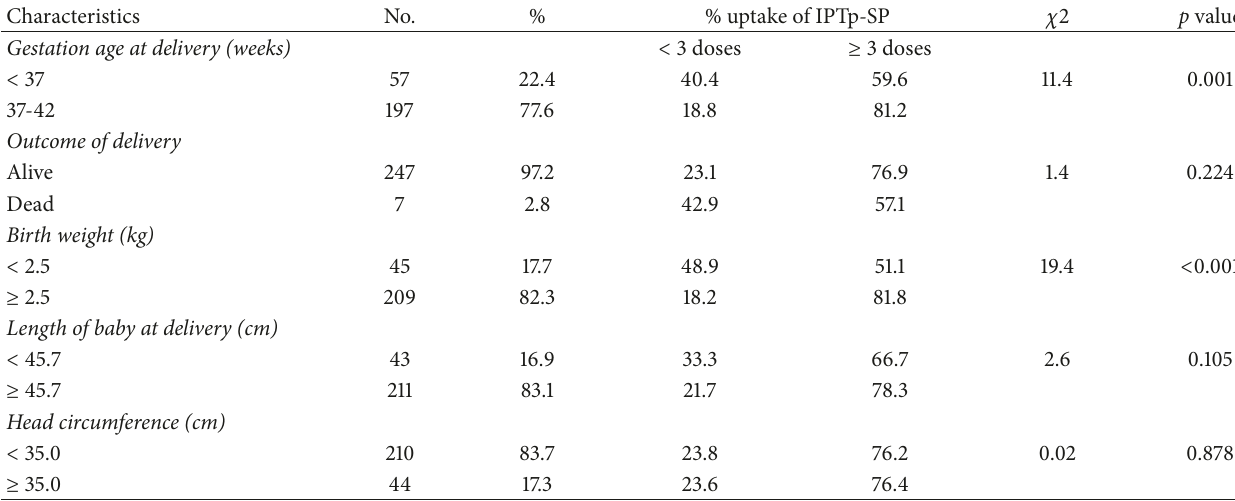
Table 4: IPTp-SP uptake, gestation at delivery, outcome of delivery, and anthropometric indices of babies.